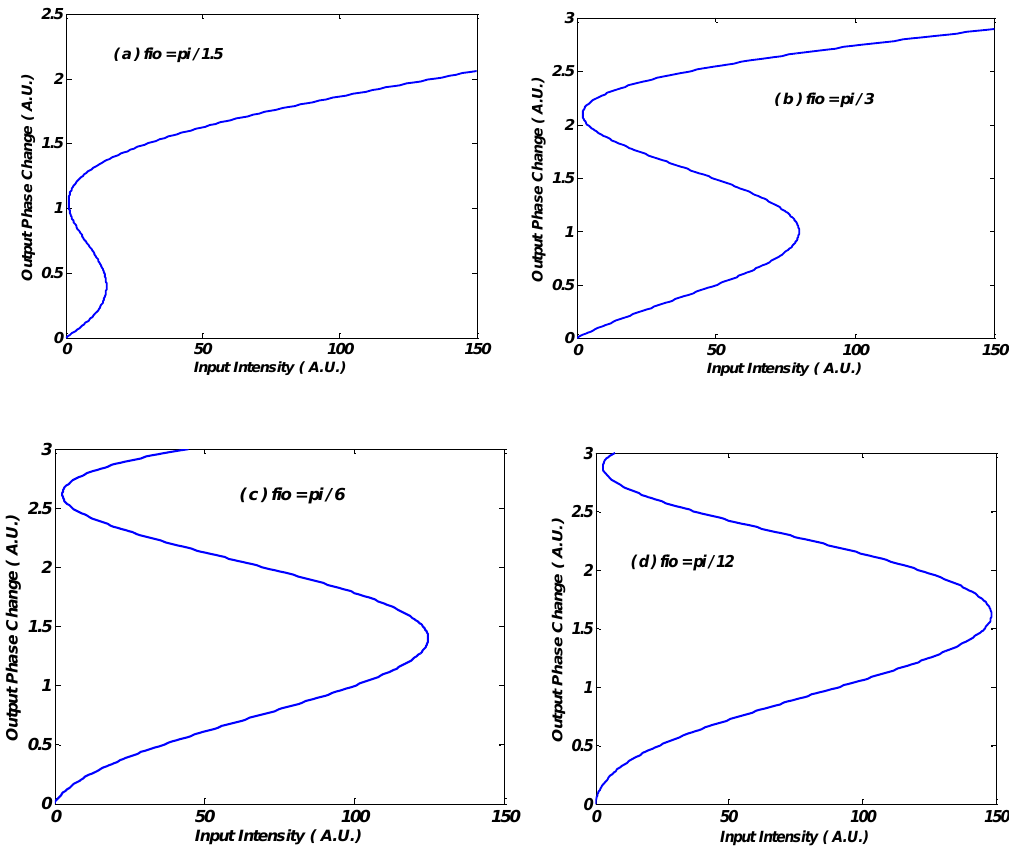
Fig.5: Input-Output characteristic for a nonlinear Fabry-Perot etalon of finesse value (F=100) and using different initial